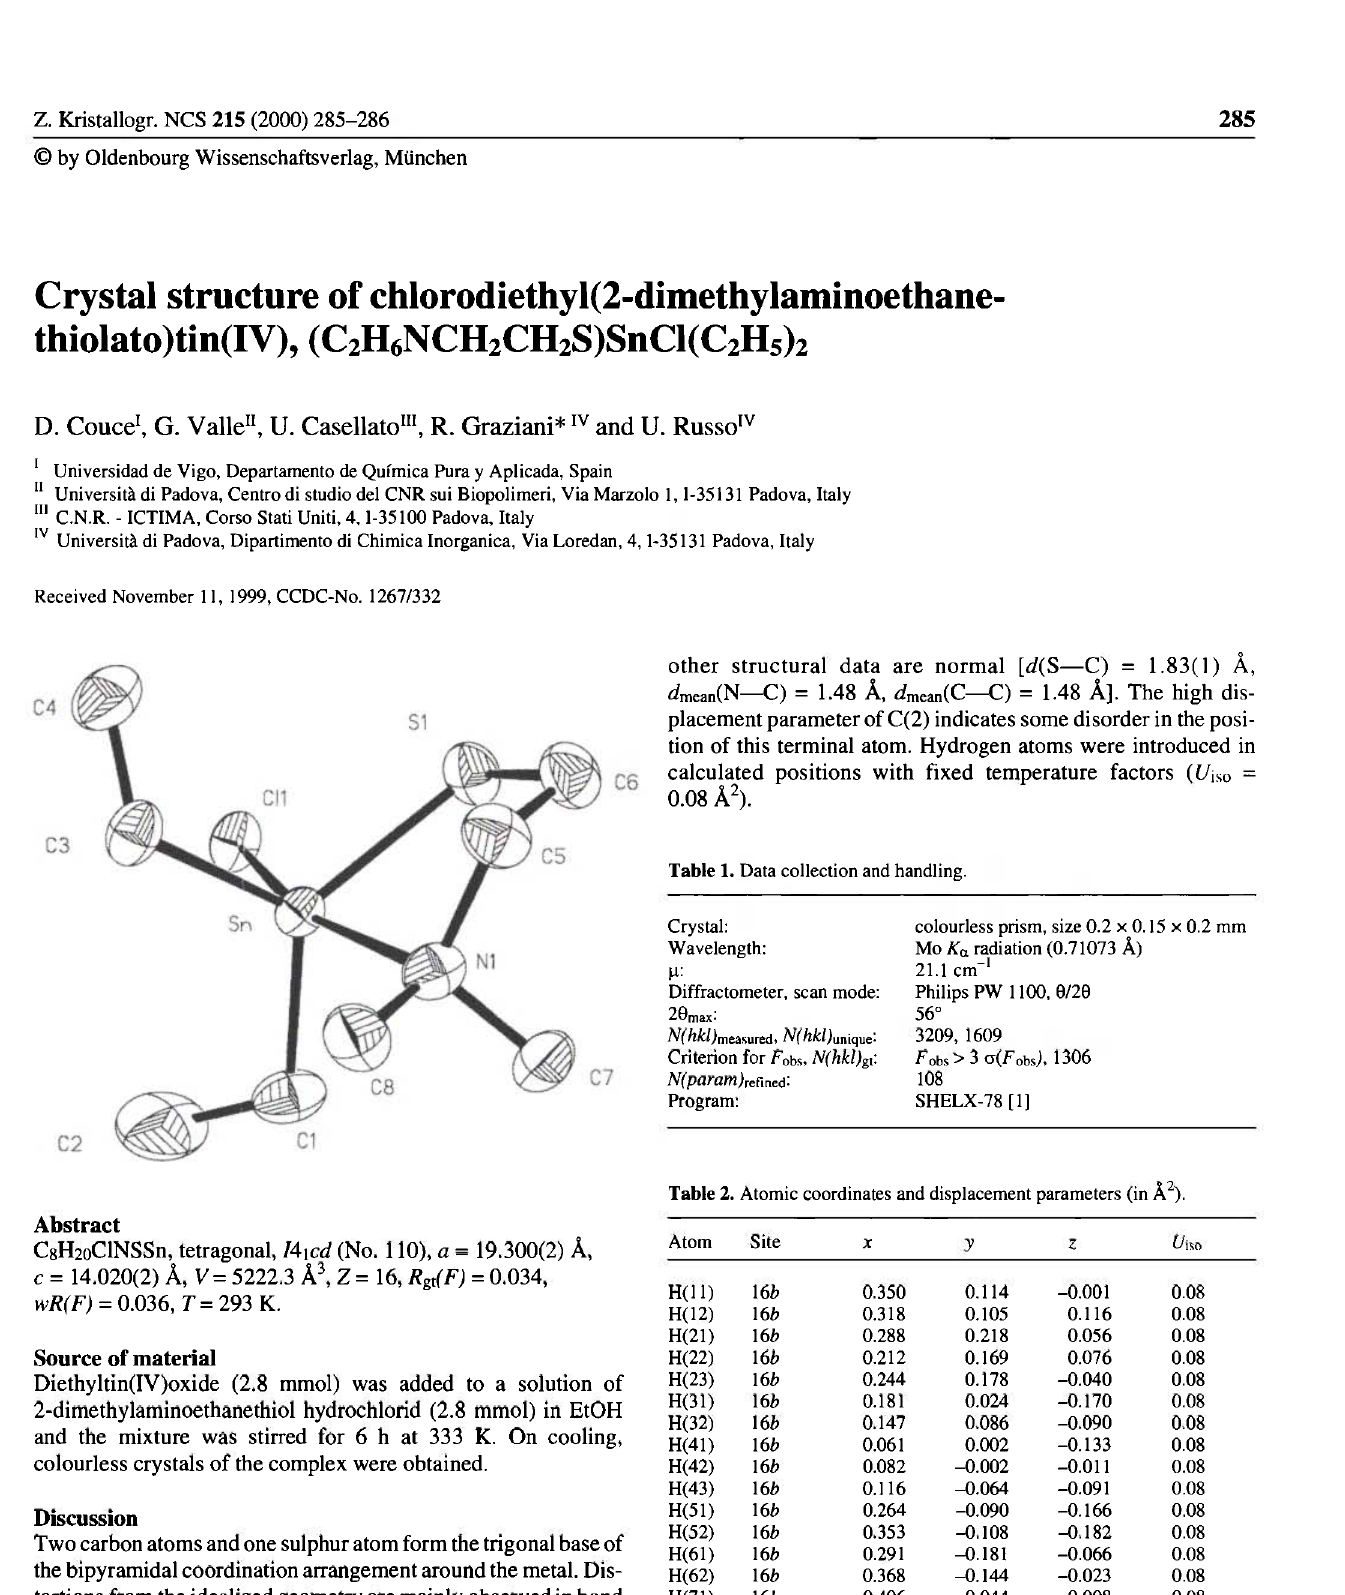
Table 2. Atomic coordinates and displacement parameters (in Ä 2